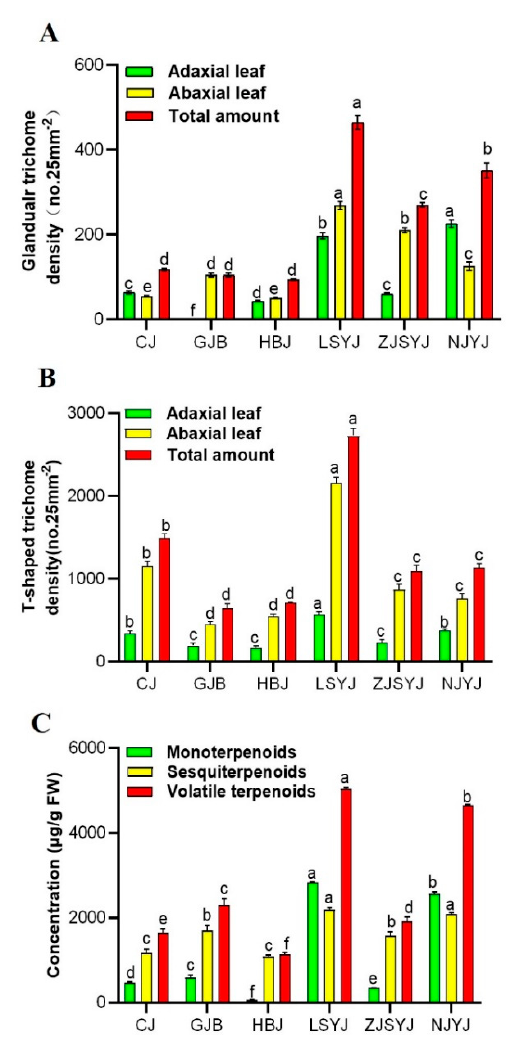
Figure 3. Measurement of trichome density and identification of terpene substances on the leaves of three cultivars of C. morifilium (‘CJ’, ‘GJB’ and ‘HBJ’) and three accessions of C. indicum (‘LSYJ’, ‘ZJSYJ’ and ‘NJYJ’). Glandular trichome ( A ) and T-shape trichome ( B ) density was measured per 25 mm 2 on the abaxial surface and adaxial surface of the fifth leaf. The terpenoid compound content in the seventh leaf is also shown ( C ). Data are presented as means ± SD (n = 3). Different letters in ( A – C ) denote statistically significant differences among cultivars\accessions according to ANOVA analysis ( p < 0.05).